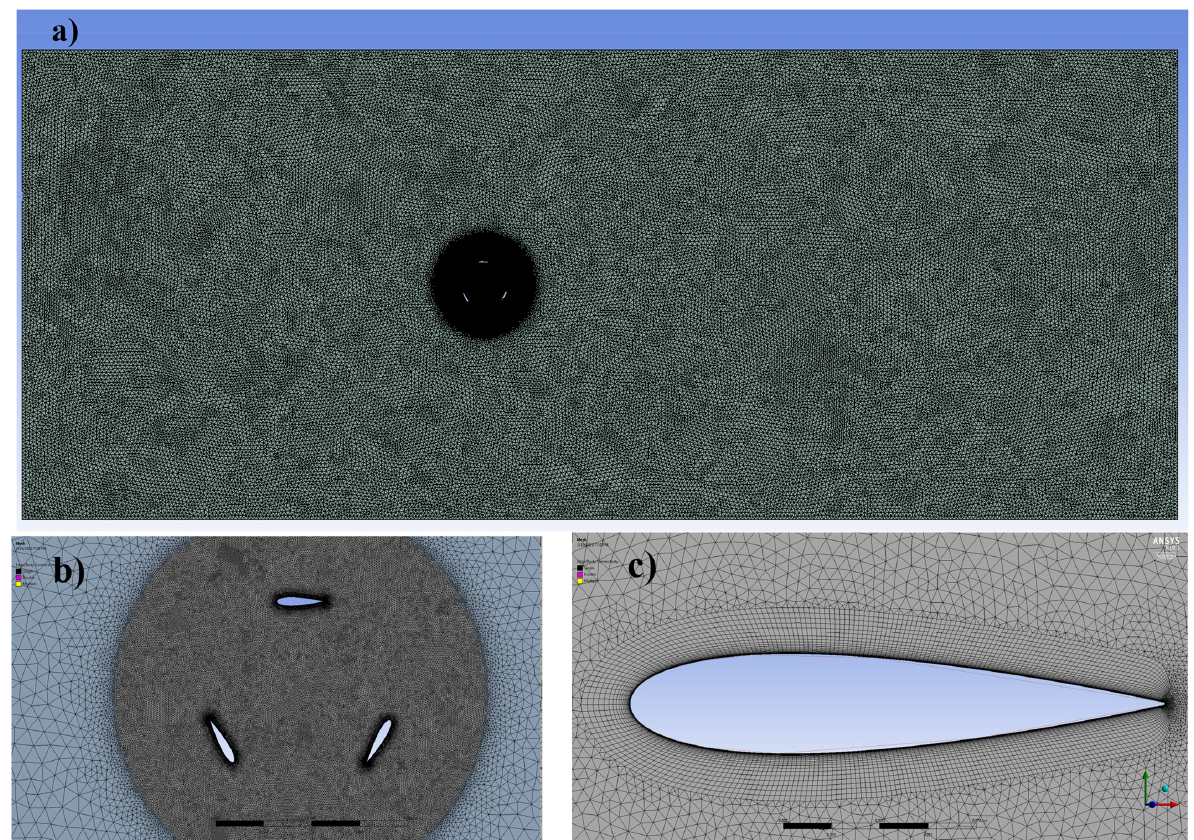
Figure 4. Medium Mesh Detailed Grids: ( a ) Grids in the Entire Computational Domain, ( b ) Grids in the Rotating Domain, ( c ) Grids around Blade 1. the Rotating Domain, ( c ) Grids around Blade 1.